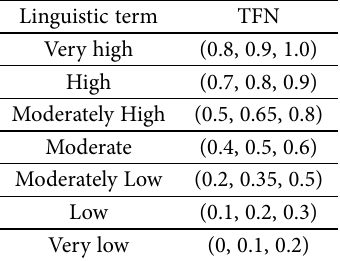
Table 3. Linguistic terms for strat- egy performance in attributes